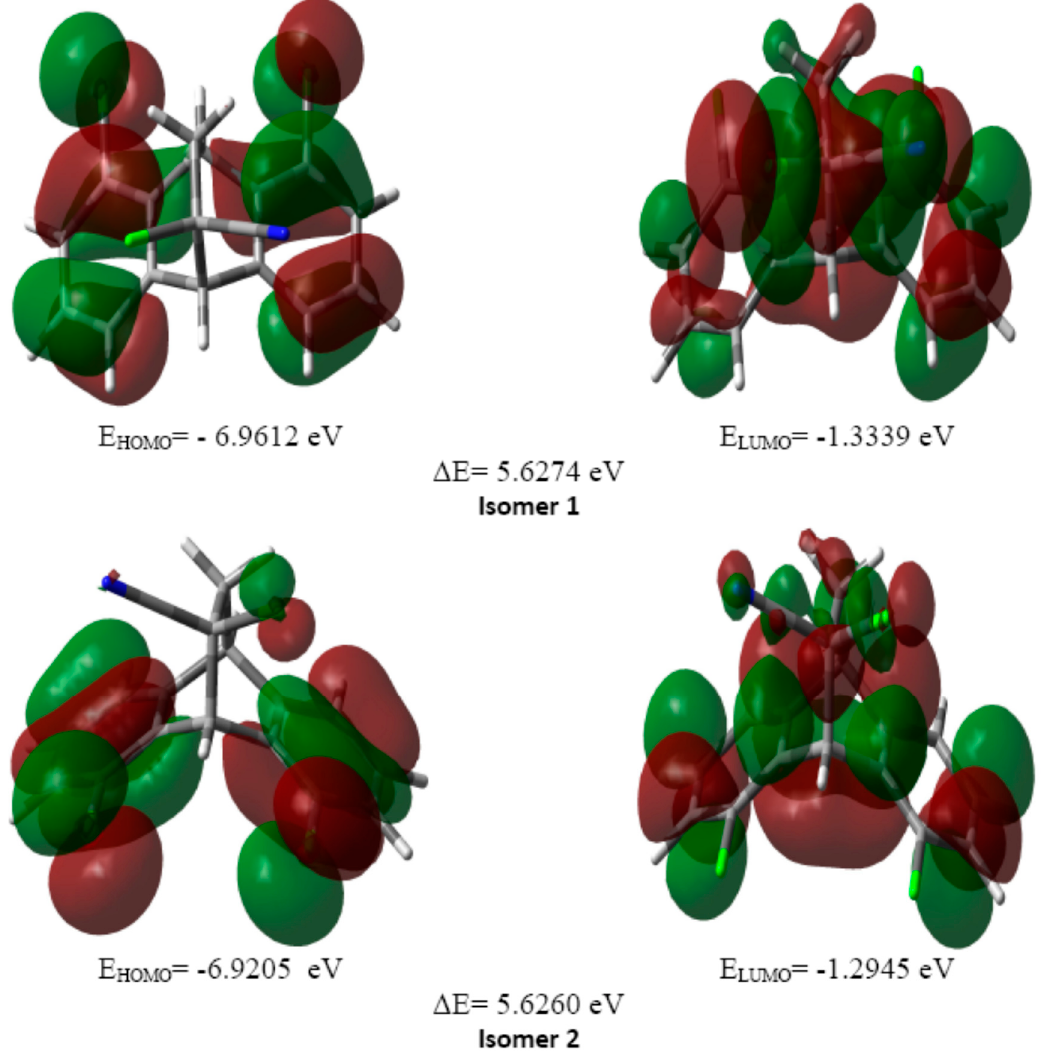
Figure 4. Molecular orbital surfaces of the HOMO and LUMO energy levels of regioisomers 1 and 2 computed at the B3LYP/6-31G(d,p) level.